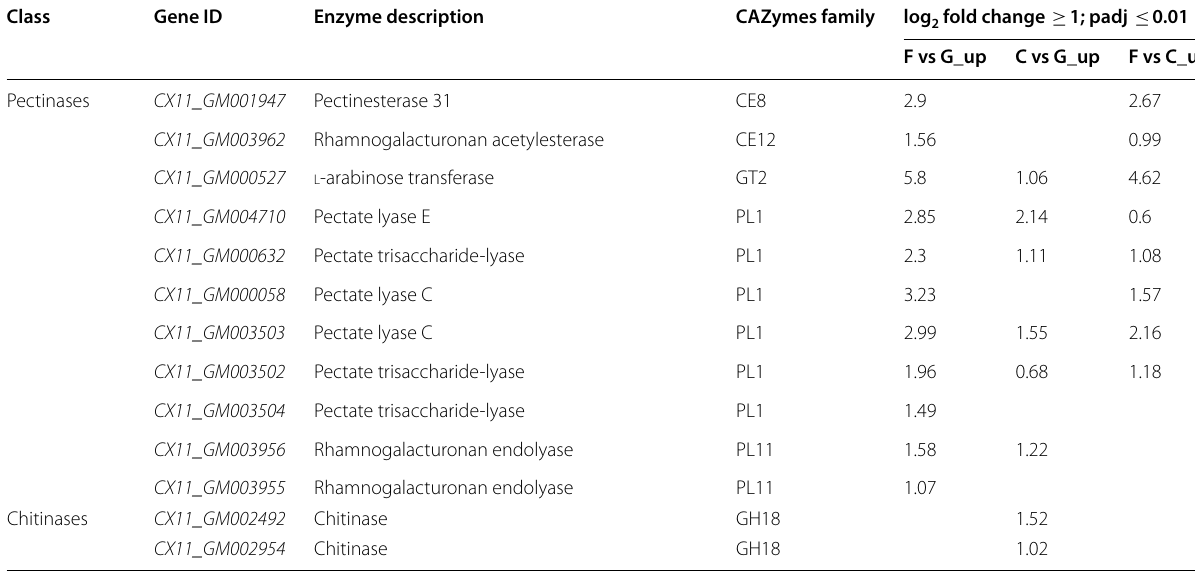
Fig. 3C, the upregulated CAZymes were mainly distrib- uted in the GH family, accounting for 48% (F vs G_up), 43% (C vs G_up) and 49% (F vs G_up), respectively. By adjusting the screening threshold to |log 2 FC| p 0.01, 54 significantly upregulated carbohydrate-active ≤ enzymes were further screened, mainly including cellu- lases, hemicellulases, pectinases, etc. (Gouvêa et al. 2018) ( \* MERGEFORMAT Table